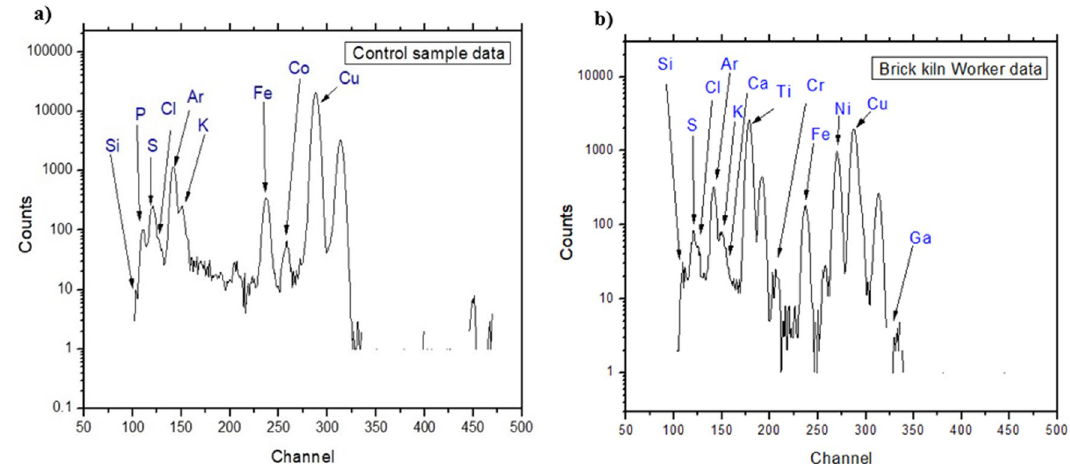
Figure 2. PIXE analysis of blood samples from ( a ) control subjects and brick kiln occupants ( b ) using 3 MeV proton energy at the National Centre for Physics, Islamabad, using a 5 MV tandem Accelerator. Note the difference between the peaks of certain heavy metals that are absent in control data. The concentration of titanium (Ti), chromium (Cr), nickel (Ni), and gallium (Ga) are most evident in brick kiln emission exposed